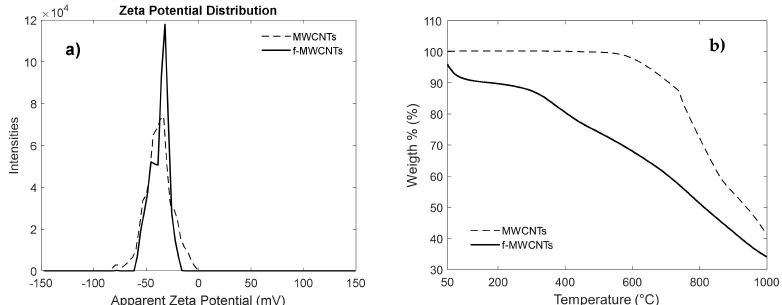
Figure 1. ( a ) Zeta potential distribution of the multi-walled carbon nanotubes (MWCNTs) solutions used before and after the chemical oxidation. ( b ) Thermogravimetric analysis (TGA) measurements for MWCNTs and carboxyl-functionalized MWCNTs. The loss of mass for functionalized material under 400 ◦ C indicates the presence of functional groups attached to the MWCNTs during the oxidation